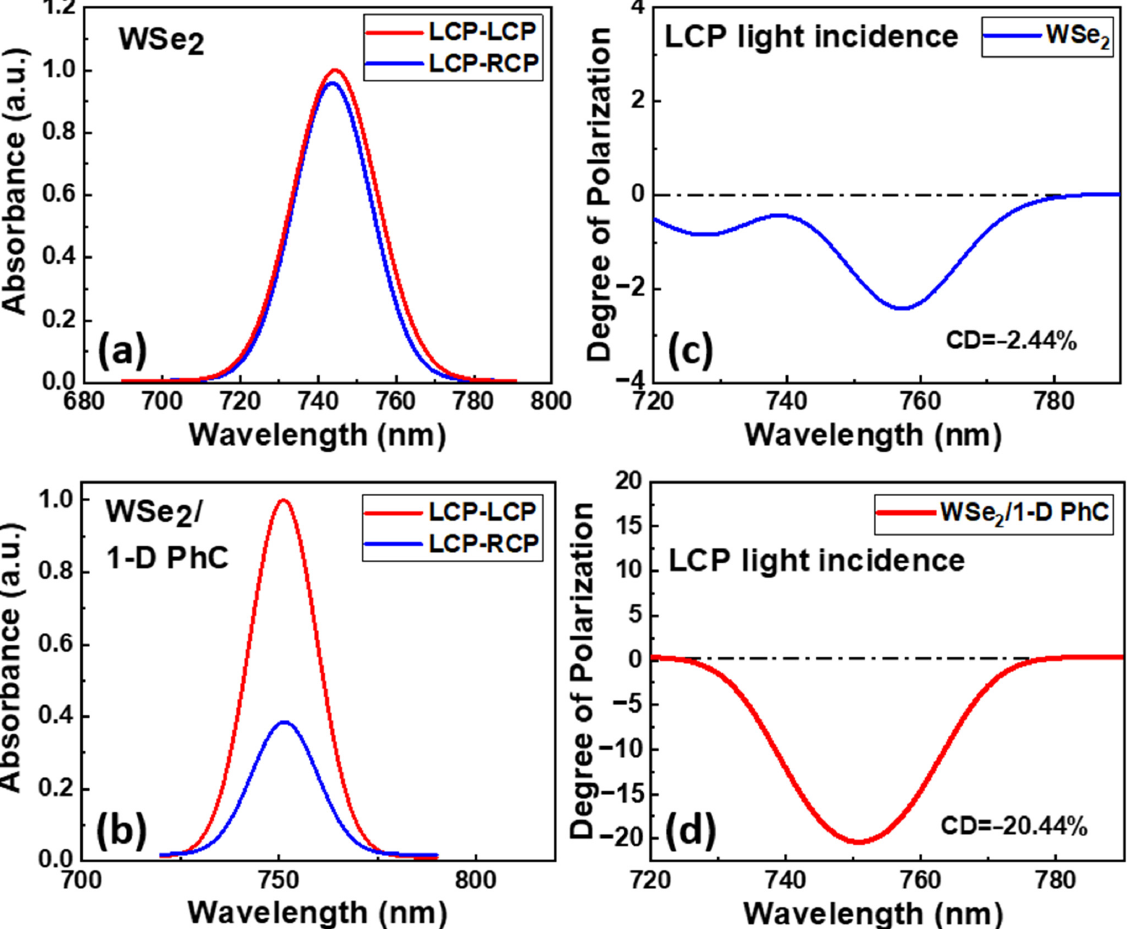
Figure 9. ( a , b ) Circularly polarized light absorption spectra for bare WSe 2 and WSe 2 /1-D PhC under LCP light incidence. ( c , d ) Degree of polarization for WSe 2 and WSe 2 /1-D PhC under LCP light incidence, respectively.